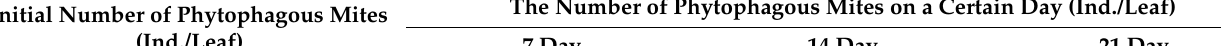
Table 9. Application results of the predatory A. andersoni and M. occidentalis against herbivorous mites on an apple tree in 2020.